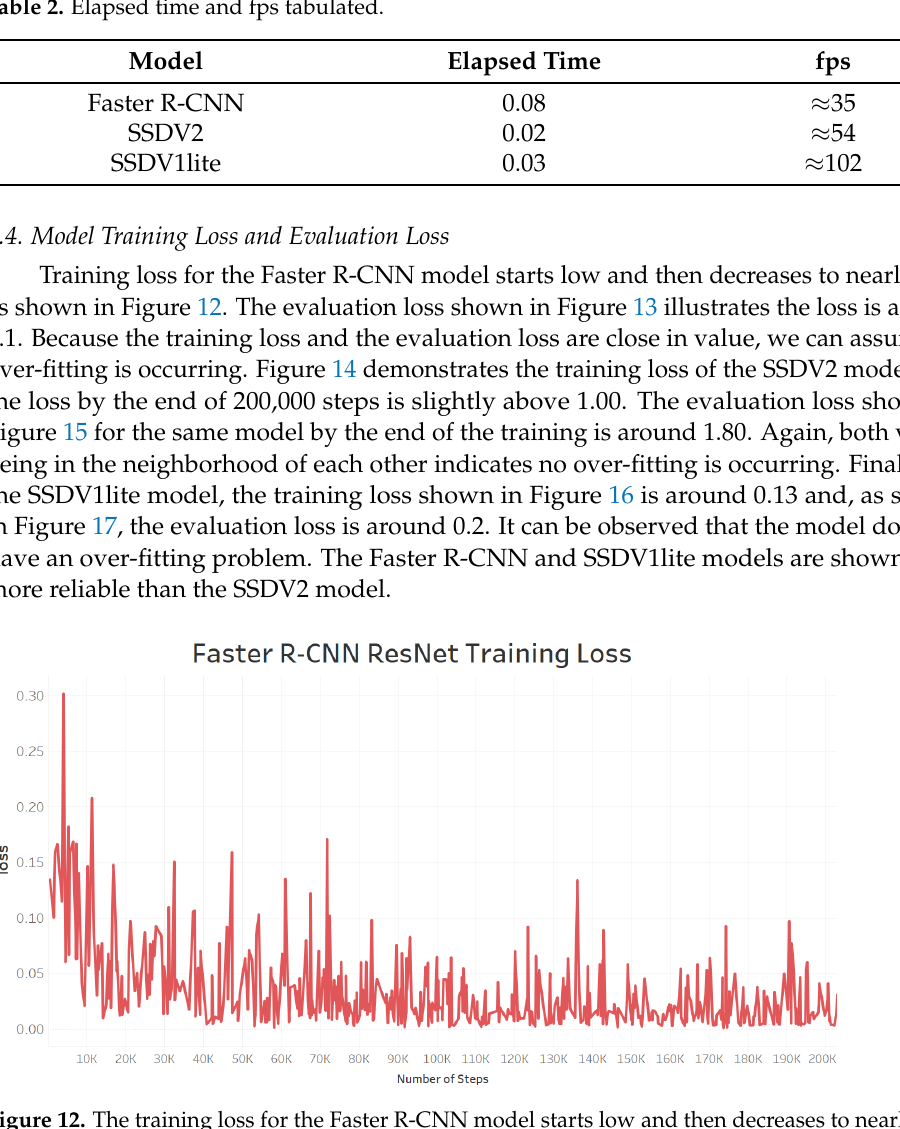
Figure 12. The training loss for the Faster R-CNN model starts low and then decreases to nearly 0.00.